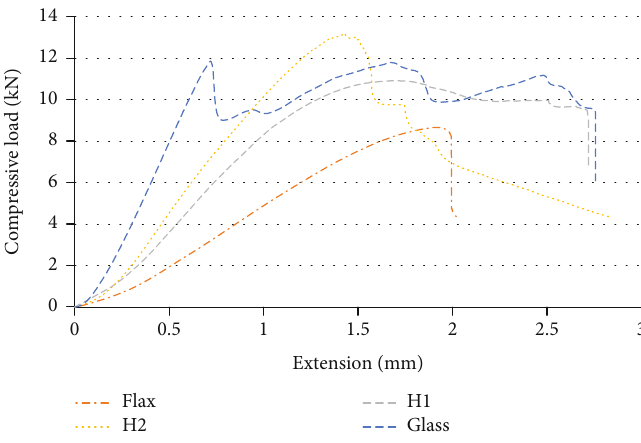
Figure 8: Load-extension curves of edgewise